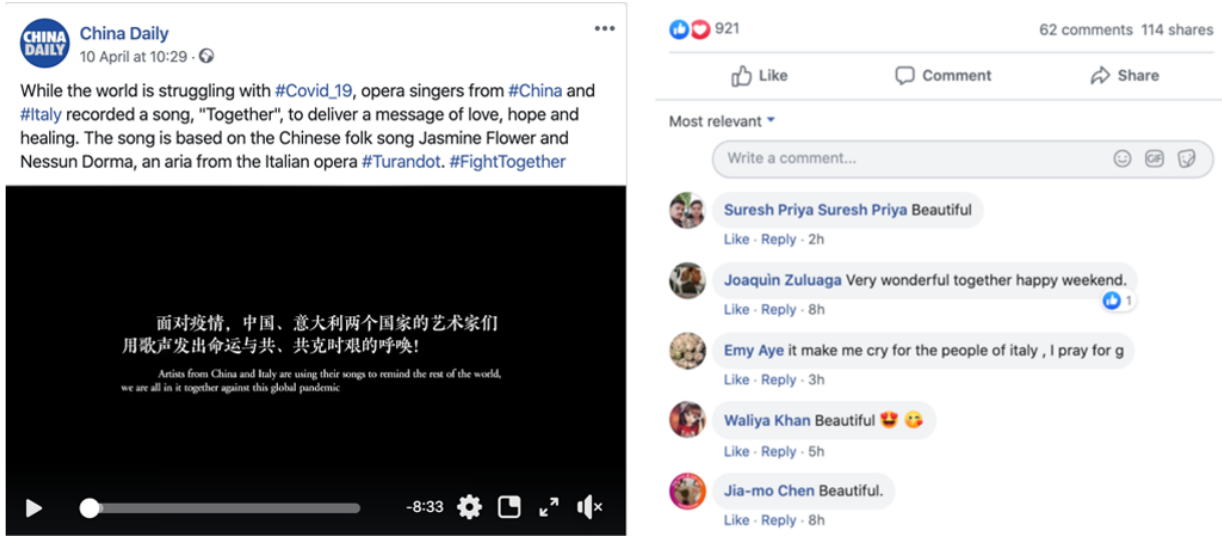
Figure 7. Screenshot of @chinadaily’s Facebook post (left) and some of the responses (right). Source: China Daily (2020).